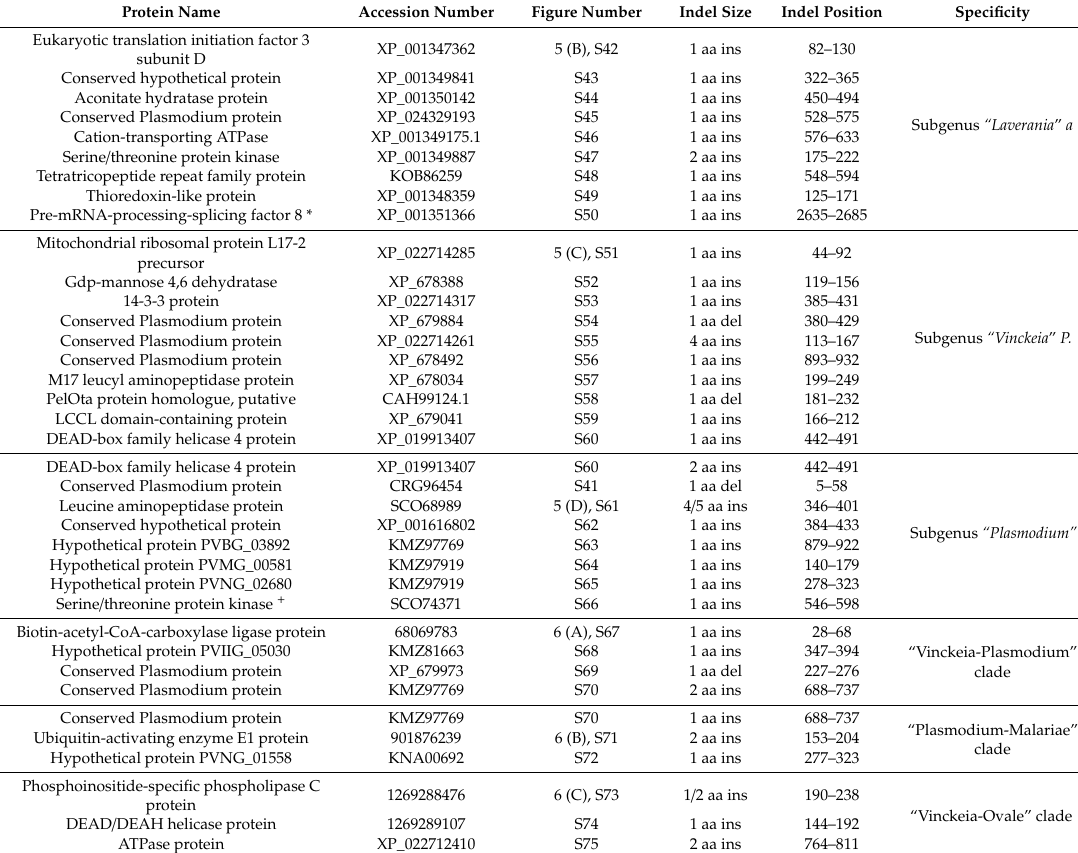
Table 3. Summary of CSIs specific for mammalian-infecting Plasmodium